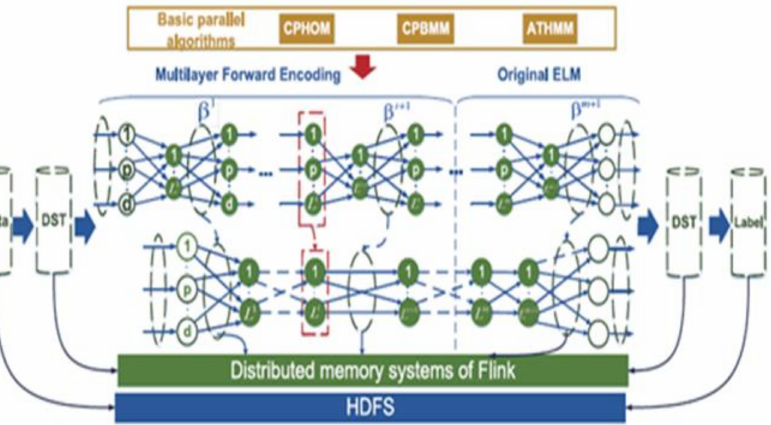
Figure 7. H-ELM GPU architecture and workflow [56]. (Reprinted with permission from ref. [56]. Copyright 2021 IEEE).